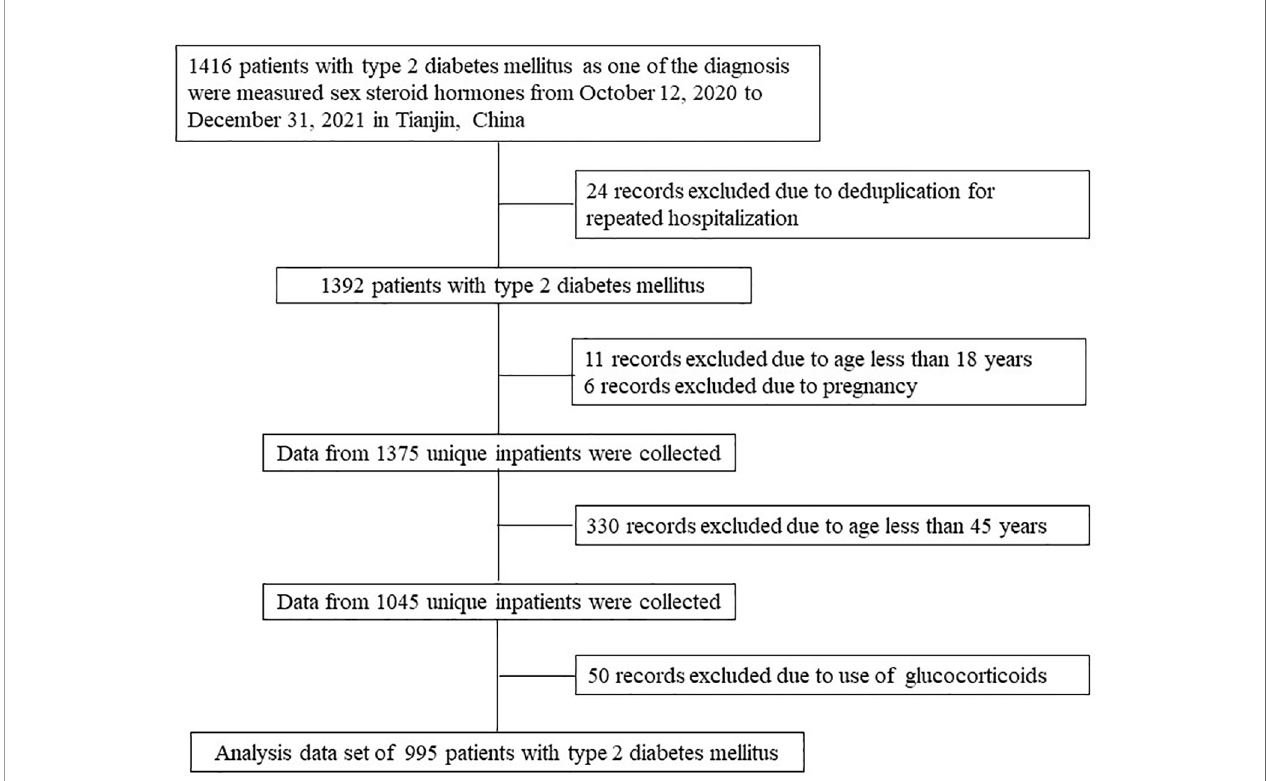
FIGURE 1 | Flow chart of the identi fi cation of the study population. Based on the exclusion criteria, 995 patients with type 2 diabetes mellitus were included in the fi nal